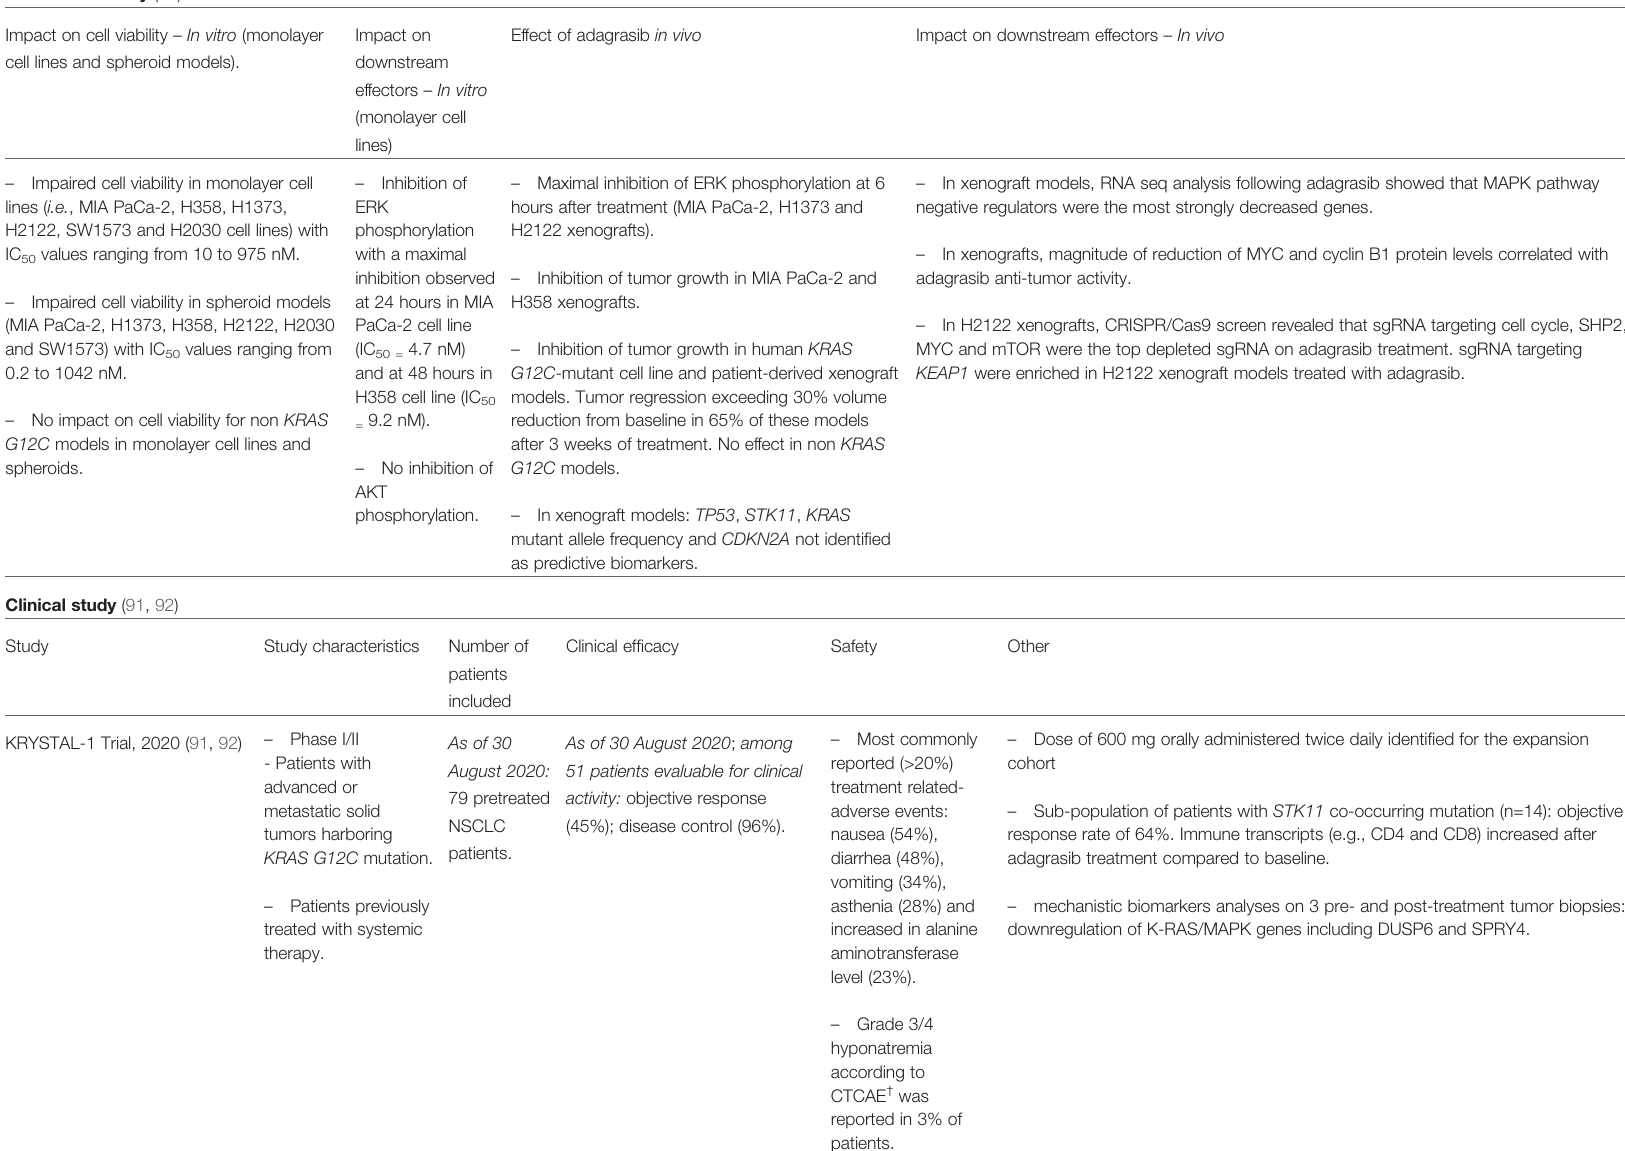
TABLE 2 | Adagrasib: Synthesis of pre-clinical and clinical development. Pre-clinical study (93) Impact on cell viability – In vitro (monolayer cell lines and spheroid